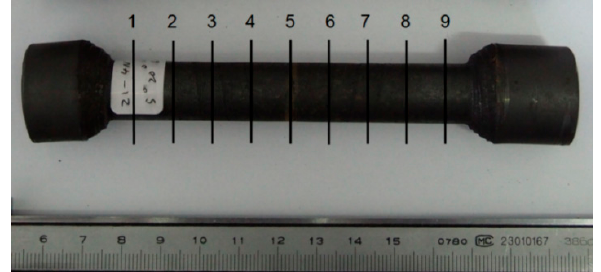
Figure 4. Positions of Diameters measured.